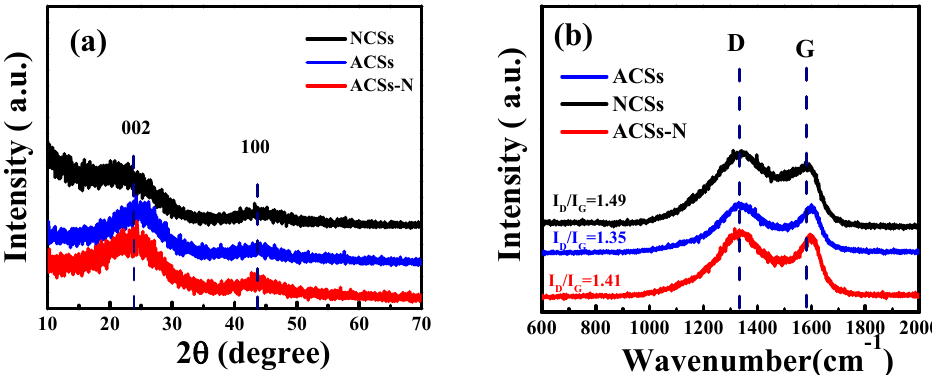
Figure 3. ( a ) XRD patterns and ( b ) Raman spectra of the porous carbons NCSs, ACSs, and ACSs-N.